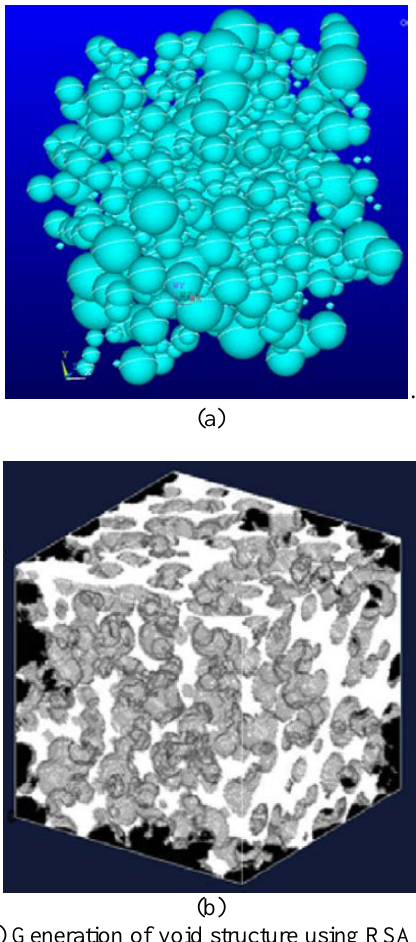
Fig. 7. (a) Generation of void structure using RSA (Random Sequential Addition). (b) Cellular material characterized by a void size